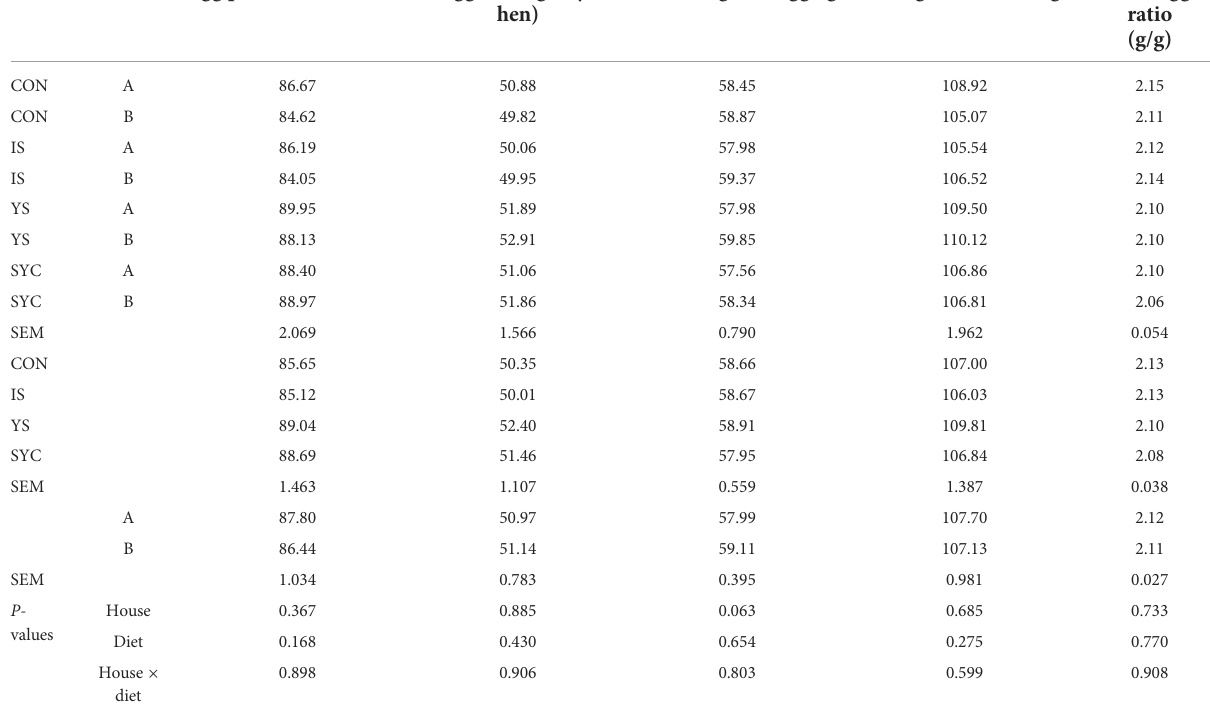
TABLE 1 Effects of different selenium sources in diets on the performance of layers before challenge by S. Enteritidis . Diets Houses a Egg production